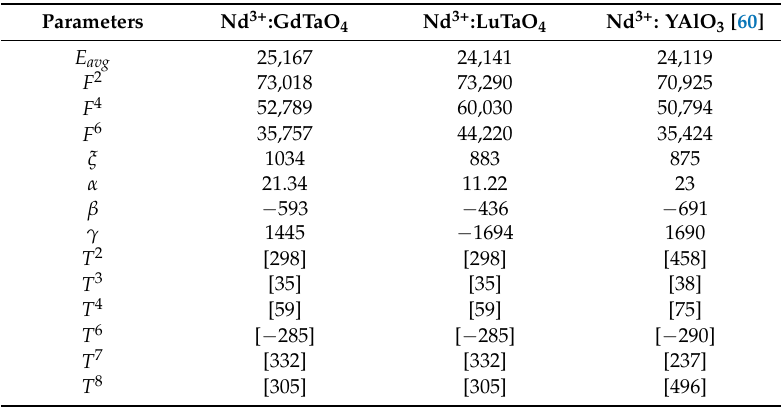
Table 10. Comparing the free-ions and crystal-field